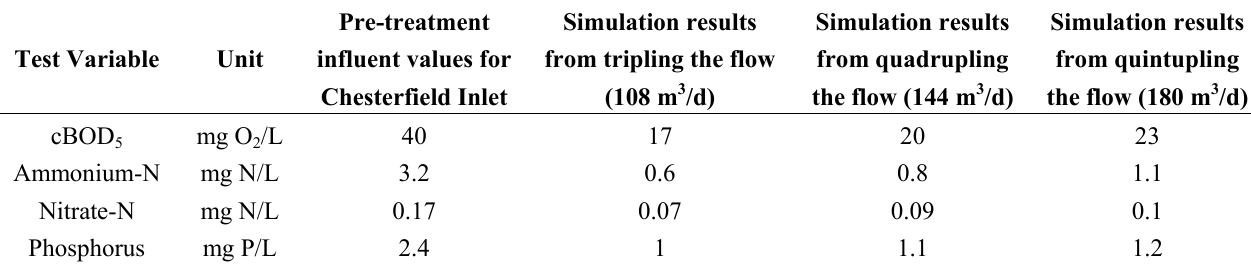
Table 3. Wastewater parameter concentrations exiting the Chesterfield Inlet tundra wetland under simulated increased effluent flows through the wetland. The mean observed temperature of 7.5 °C for the Chesterfield Inlet wetland was kept in this scenario.